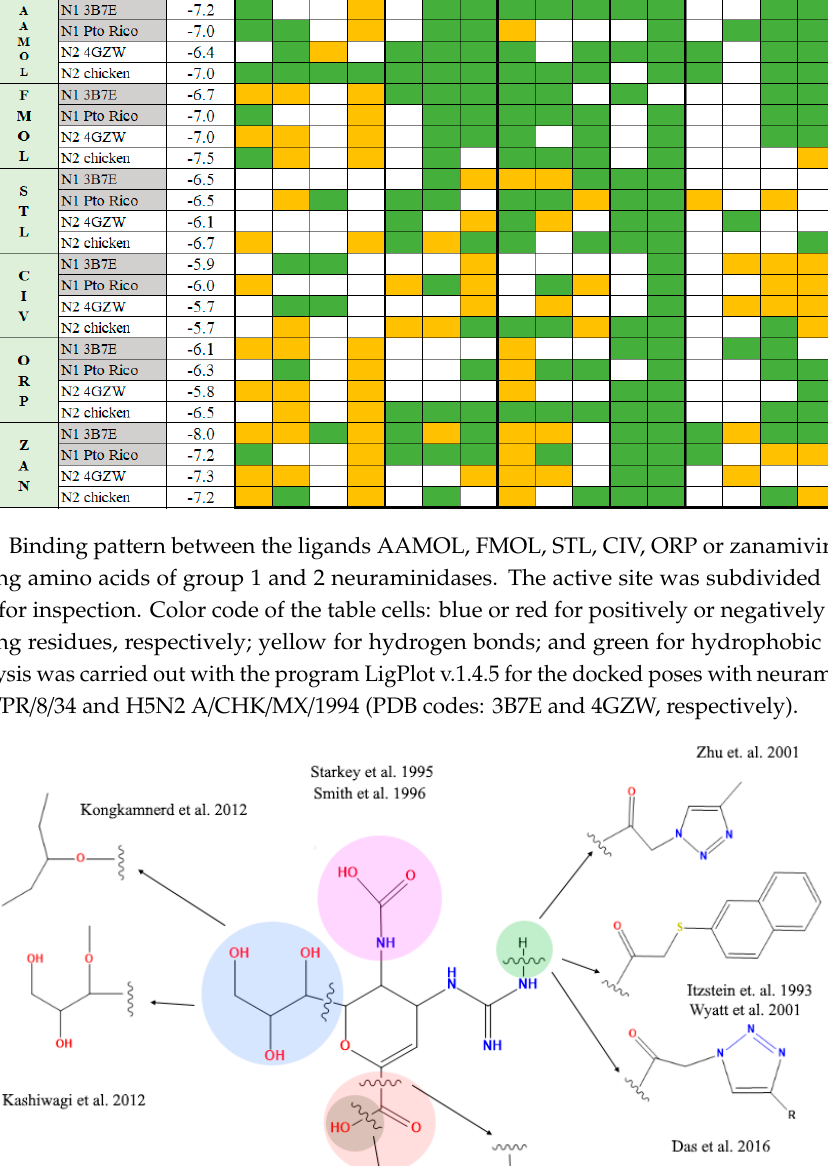
Figure 4. Binding pattern between the ligands AAMOL, FMOL, STL, CIV, ORP or zanamivir and the interacting amino acids of group 1 and 2 neuraminidases. The active site was subdivided into five subsites for inspection. Color code of the table cells: blue or red for positively or negatively charged interacting residues, respectively; yellow for hydrogen bonds; and green for hydrophobic contacts.